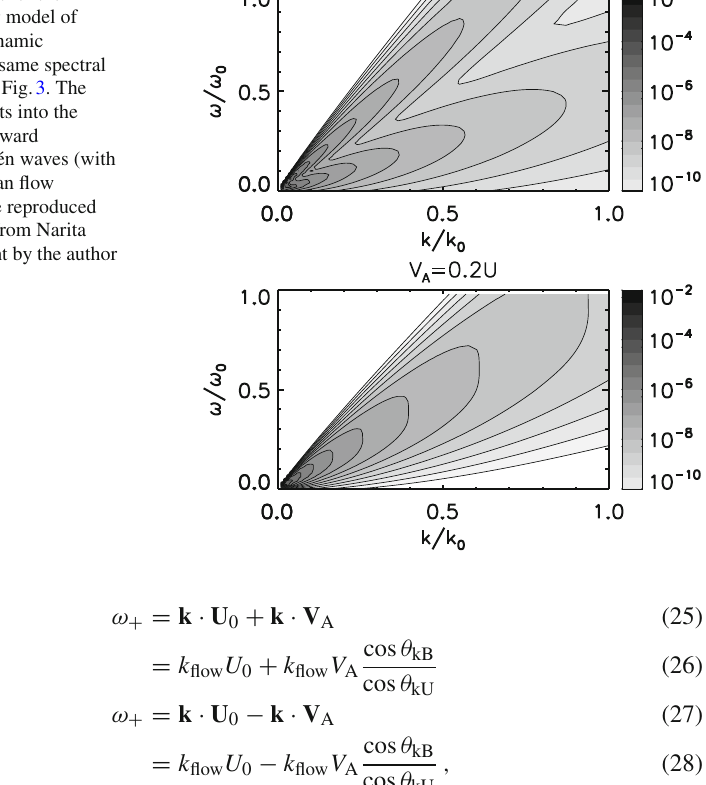
Fig. 4 Different realizations of the energy spectra for the random sweeping model of magnetohydrodynamic turbulence in the same spectral domain as that in Fig.3. The Doppler shift splits into the forward and